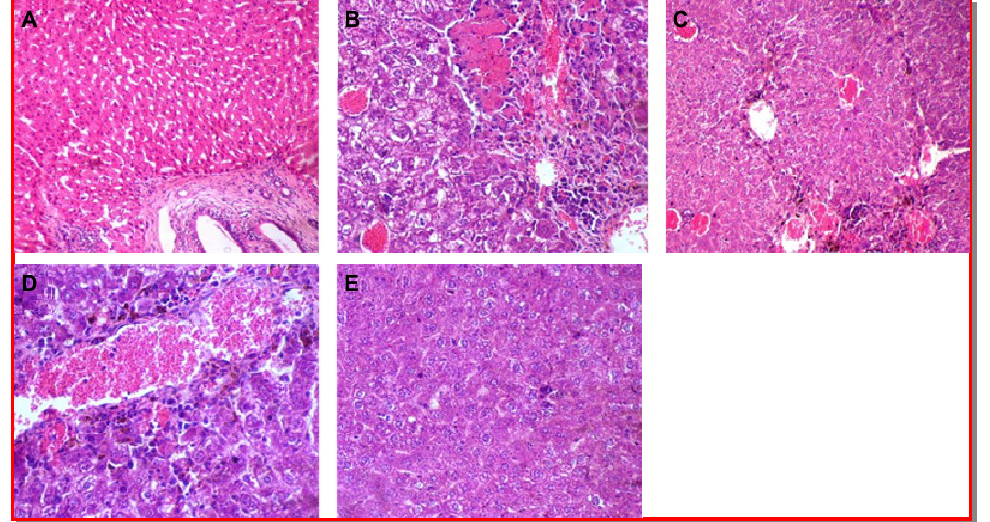
Figure 3: Photomicrograph of liver from mice administered with normal saline (A) paracetamol only, (B) paracetamol + silymarin, (C) paracetamol + SS-200, (D) and paracetamol + SS-400 (E). SS-200; 200 mg/kg of S. sebiferum , SS-400; 400 mg/kg of S. sebiferum . All figures are × 100